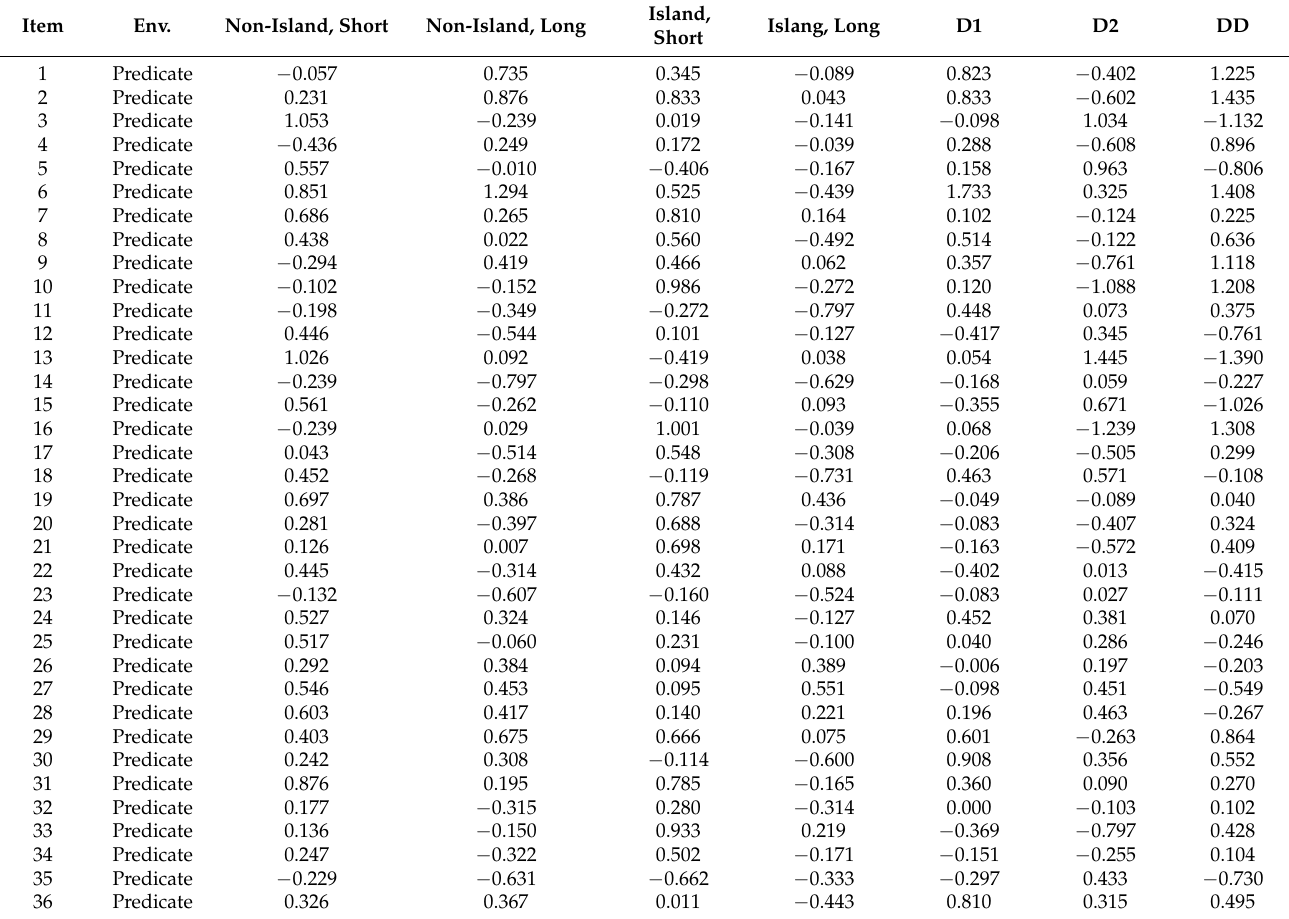
Table A7. DD score calculation table for Experiment 1, Predicate conditions. The table displays the z-scored ratings for each condition and the intermediate differences used to calculate the DD score by item. Refer to Section 2 for a description of the procedure for calculating DD scores. The DD scores below are averaged for the Predicate environment and presented in Figures 2 and 11.